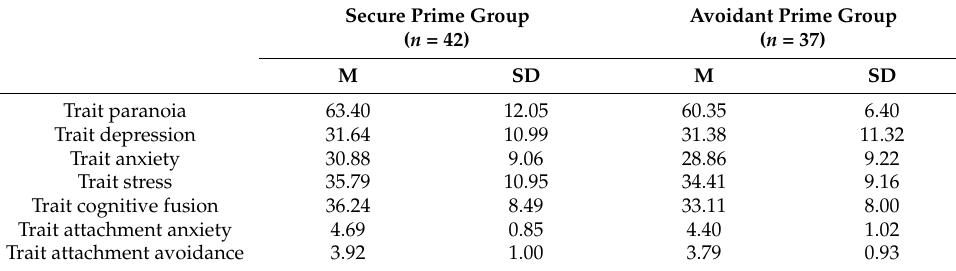
Table 1. Descriptive statistics for trait characteristics.